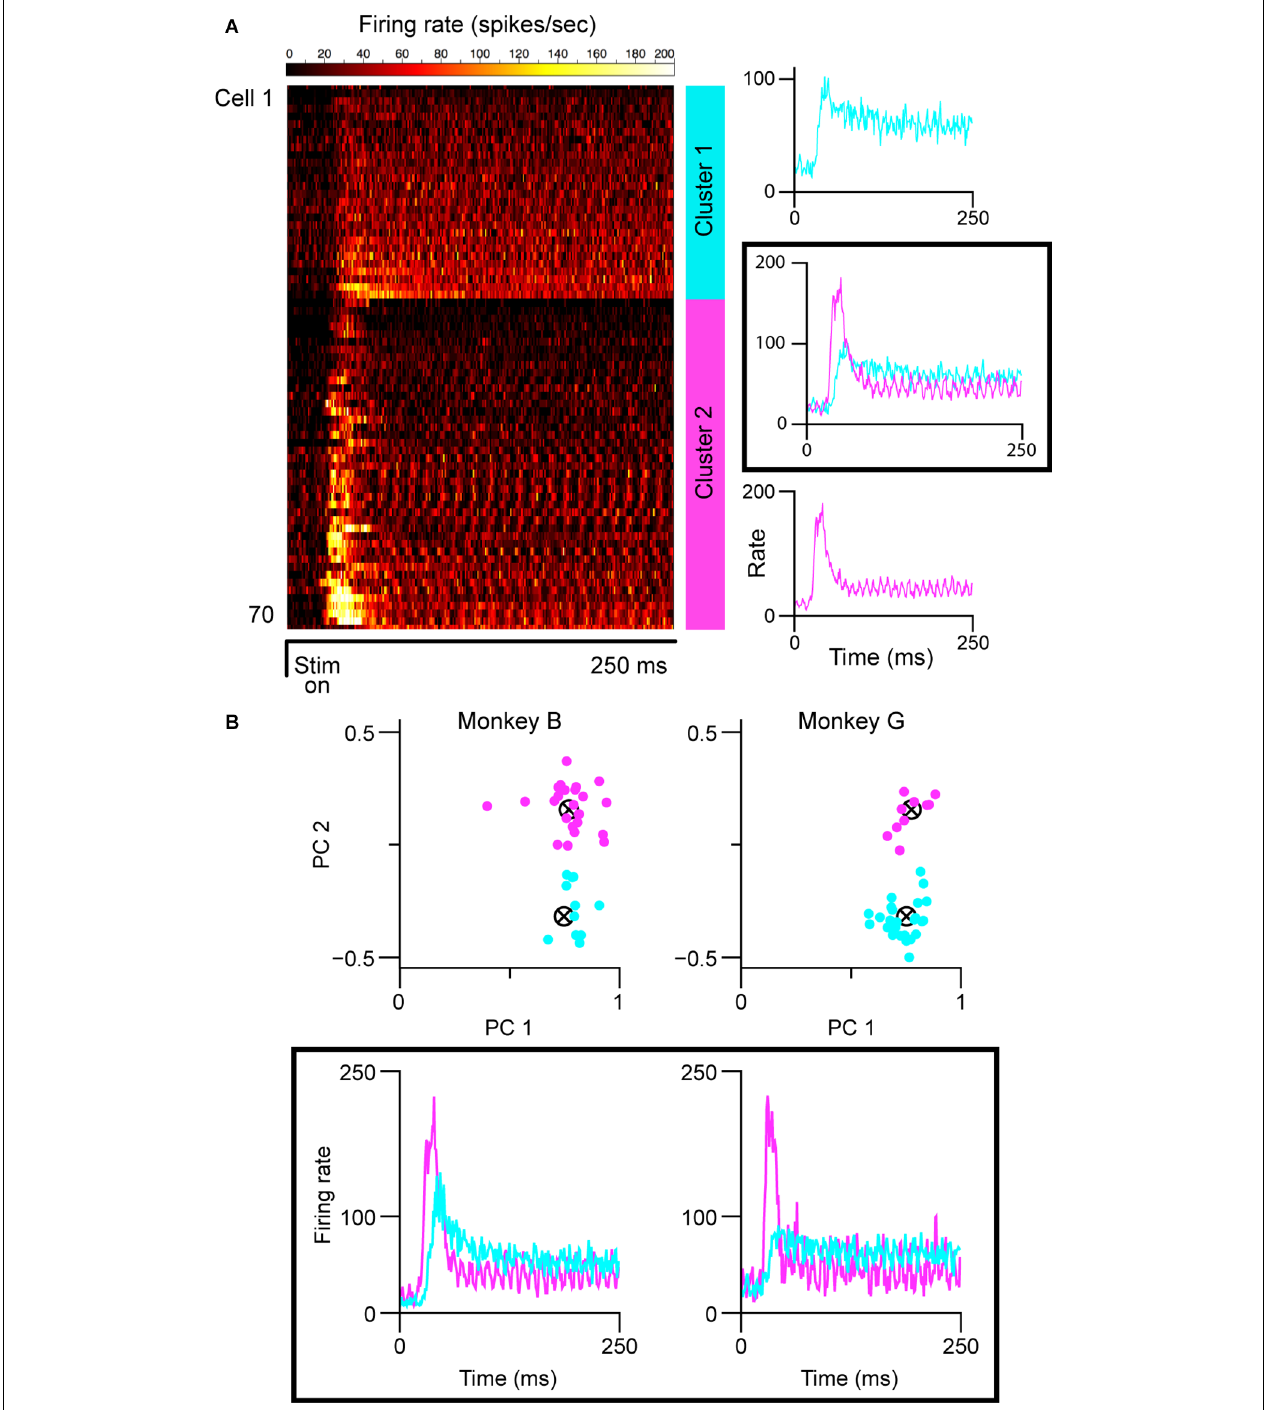
FIGURE 1 | Cell partitioning based on spiking responses elicited by static gratings. (A) Results of AP algorithm. Mean spiking responses of all cells in this experiment are shown on the left ( n = 71). Two clusters were found (mean group firing patterns shown at right): one with sustained spiking responses, longer latencies, and lower peak firing rates, and one with transient spiking patterns, shorter latencies, and higher peak firing rates. The “ripples” in the firing patterns of the transient group are caused by the cells responding to the monitor refresh (100 Hz). (B) Results of k-means clustering. Clustering run separately for each monkey shown at top; scatterplot shows the projection of normalized responses onto the first two principal components of the respective data matrices. Clustering was seeded with two centroids. Mean spiking response patterns from each group are shown at the bottom. In all panels, putative magnocellular neurons indicated in magenta, putative parvocellular neurons indicated in